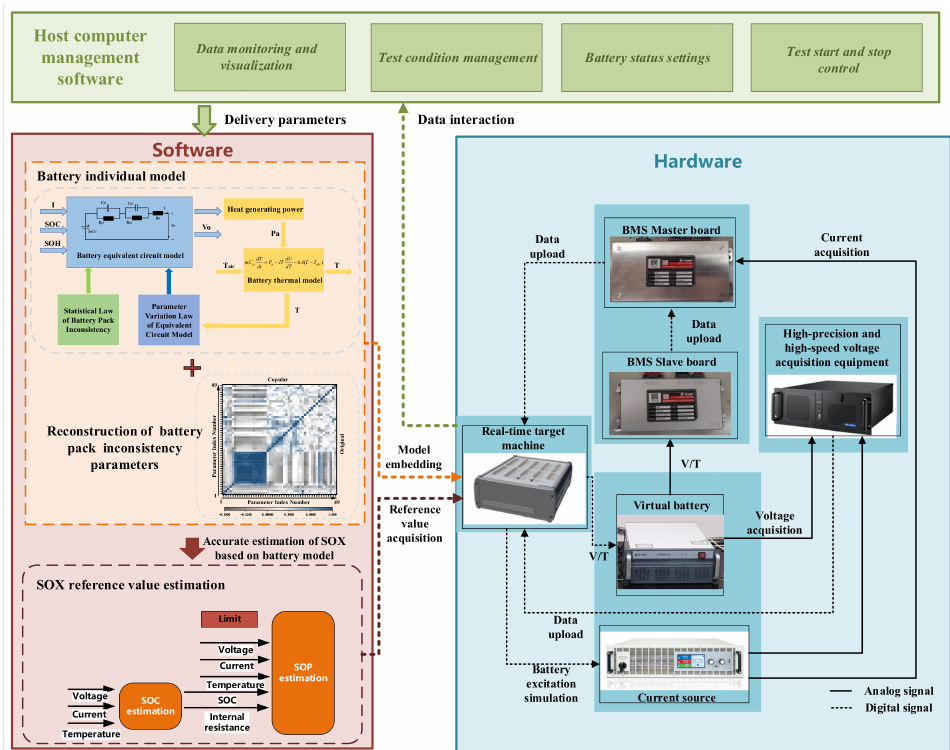
Figure 3. Schematic diagram of BMS testing